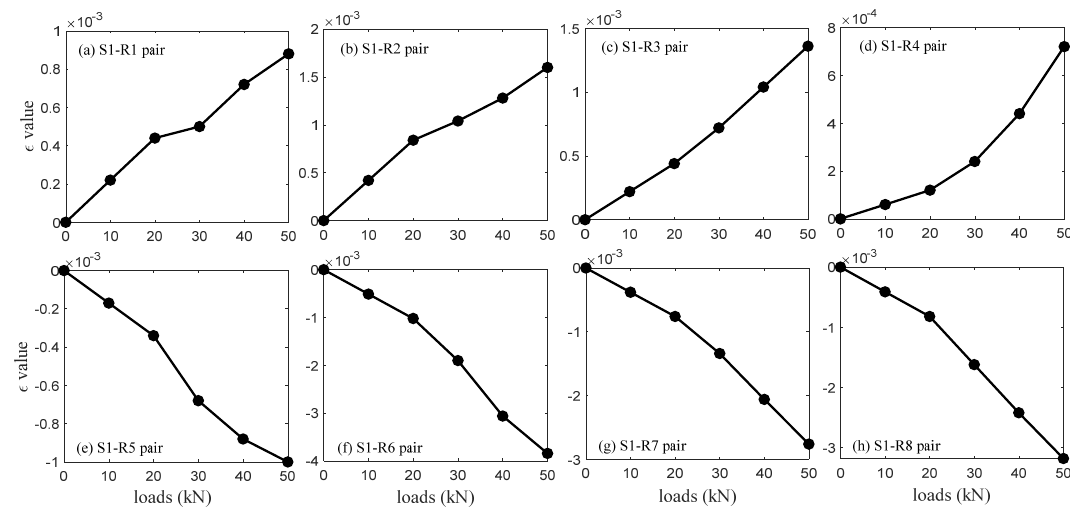
Figure 10. The ε values corresponding to the source S1 excitation and receivers R1 ∼ R8 measurements.